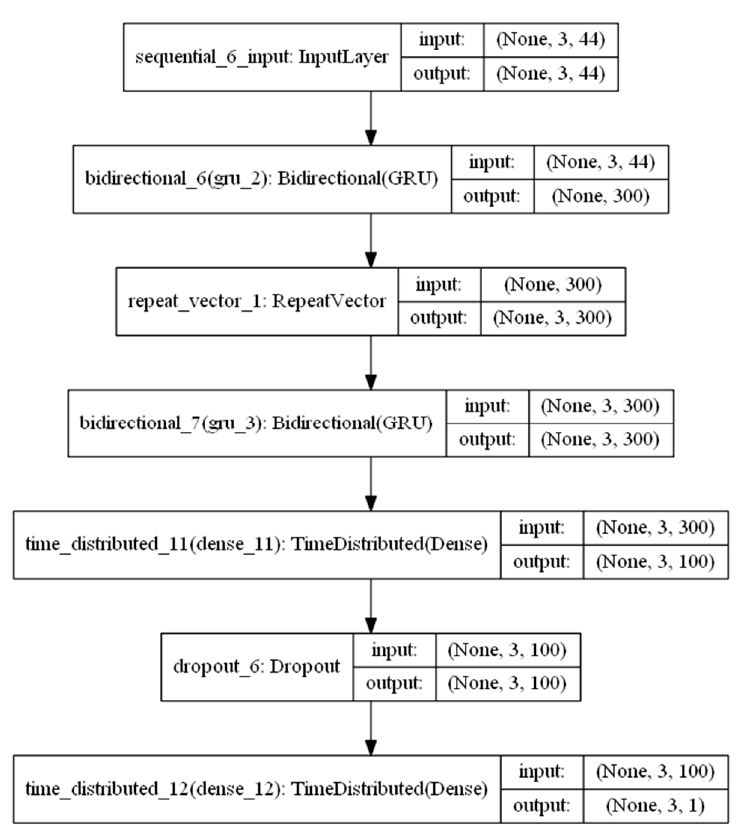
Figure 15. Model based on Architecture 3: encoder–decoder architecture.